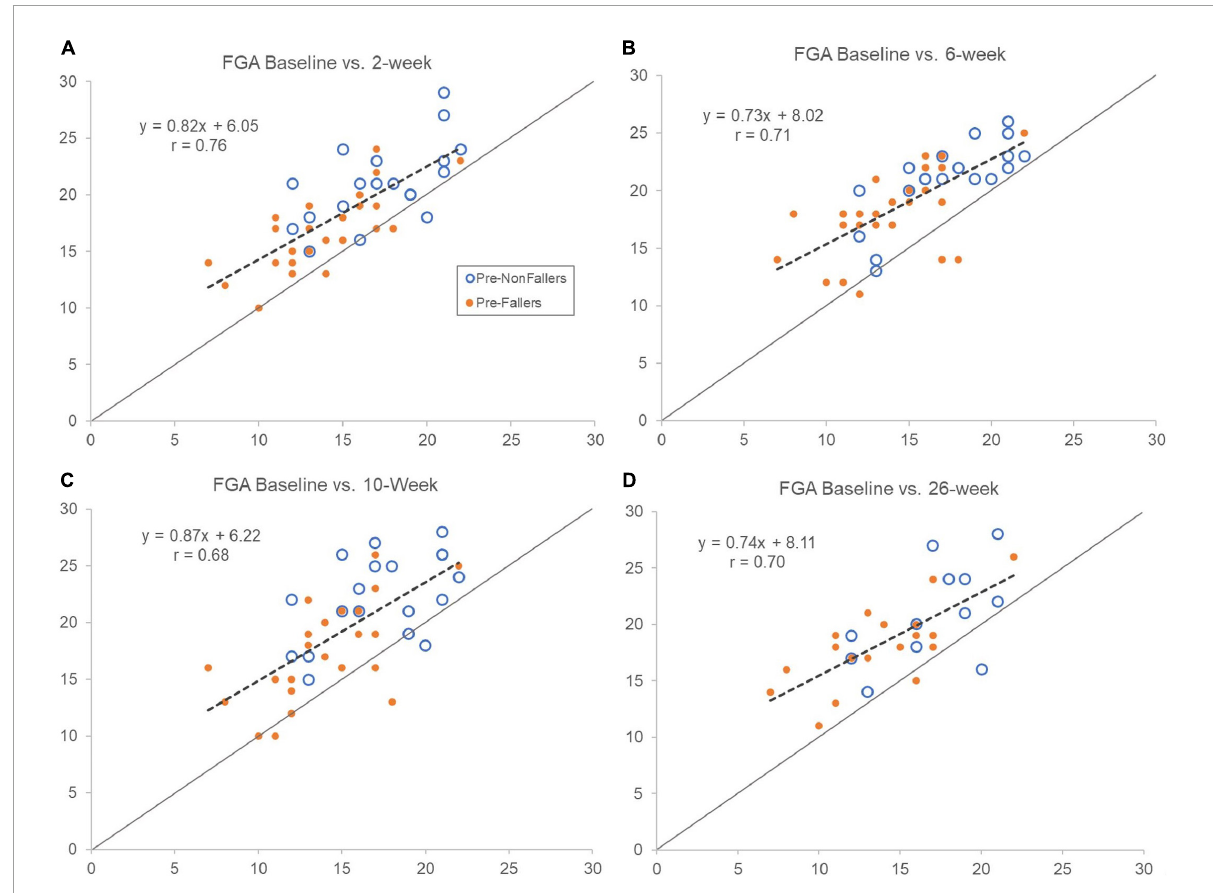
FIGURE3 Comparing FGA scores at baseline (horizontal axes) with assessments after 2 (A) , 6 (B) , 10 (C) , and 26 (D) weeks (vertical axes) of device use. Open symbols represent pre-study non-fallers and filled ones are pre-study fallers. Dashed lines show regression line for the whole group. Forty-four participants completed in clinic outcomes testing up to 10 weeks (primary endpoint), and 30 participants completed the 26-week assessment in person. Scores above line of equality indicate improvements and below a decrement in FGA score compared to baseline scores. Notice that regression line slopes are less than 1 indicating slightly larger improvements in FGA score for those with lower baseline scores. Overall, improvements observed after 2 weeks of use appeared sustained throughout the 26 weeks of